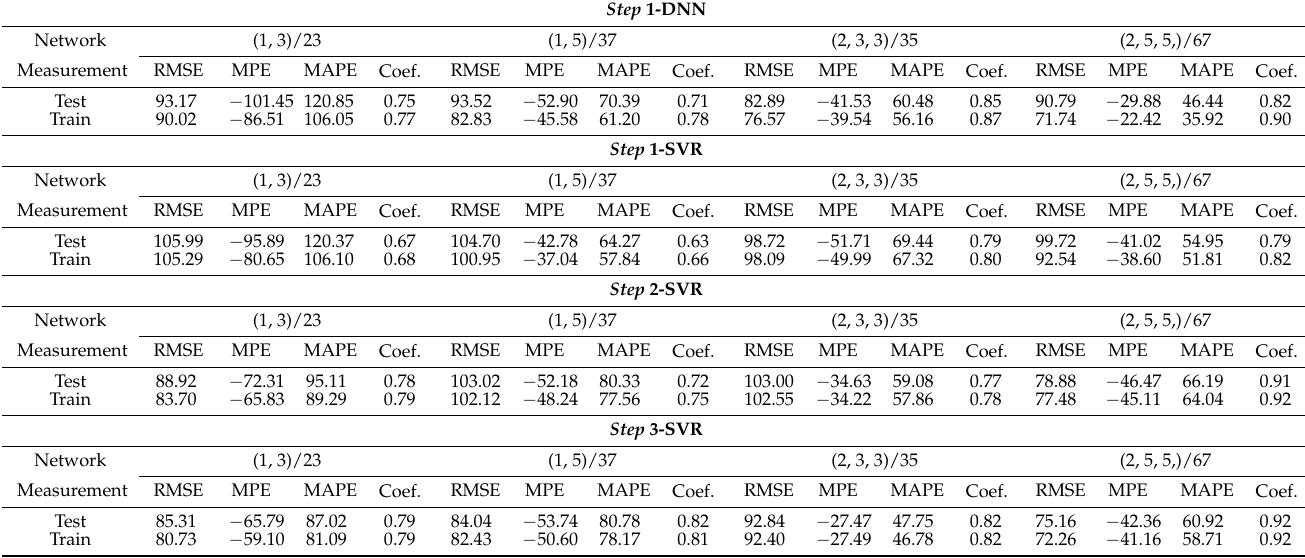
Table A2. Results of surrogate models in the cart-pole